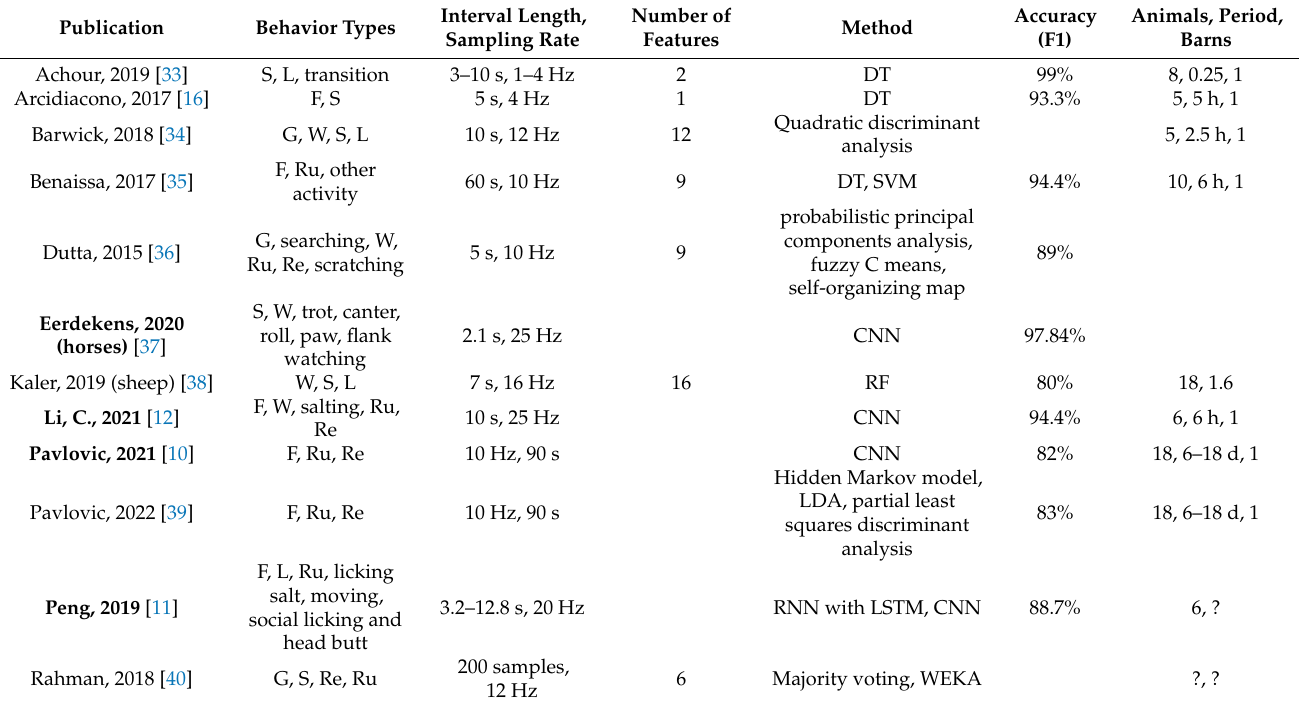
Table A1. Review of methods for dairy cow behavior recognition based on acceleration sensors. Studies using NN-based methods are highlighted in